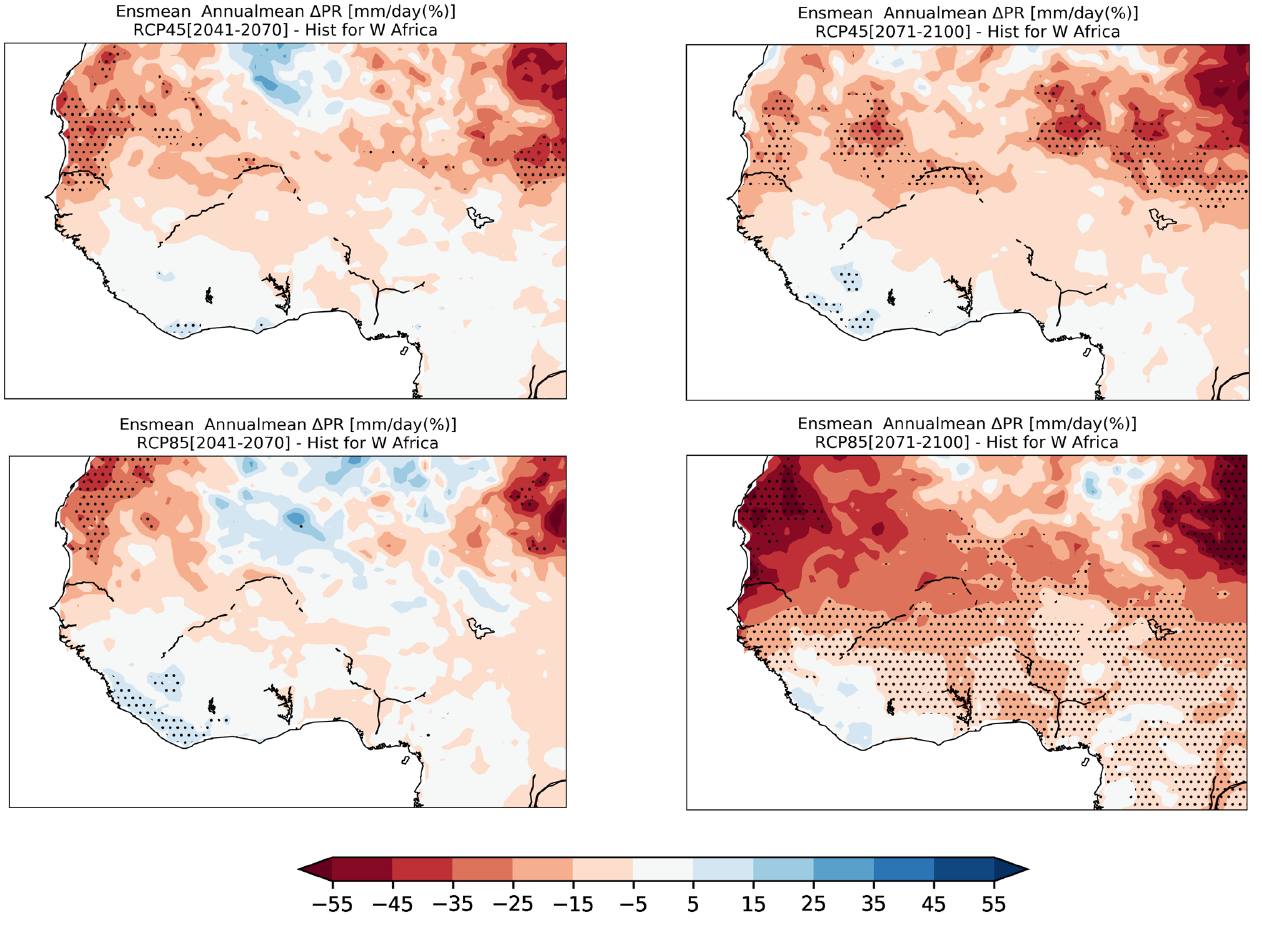
Figure 7. Projected changes in precipitation (%) for mid-future ( left column) and far future ( right column) from RCP4.5 ( top row) and RCP8.5 ( bottom row) scenarios. Regions with dots overlaid on the filled contour represent statistically significant at 0.05 level.